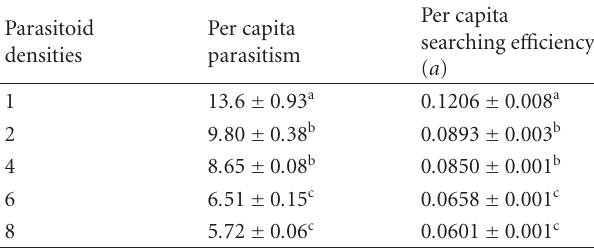
Table 3: Mean ± SE per capita parasitism and searching e ffi ciency of Praon volucre on Sitobion